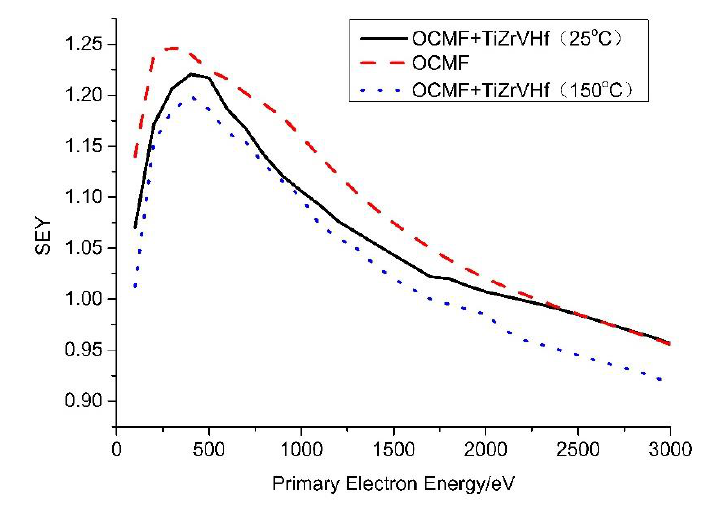
Figure 5. Secondary electron yield (SEY) curves of ( a ) OCMF substrates and Ti-Zr-V-Hf film-coated OCMF tested at ( b ) 25 °C and ( c ) 150 °C.